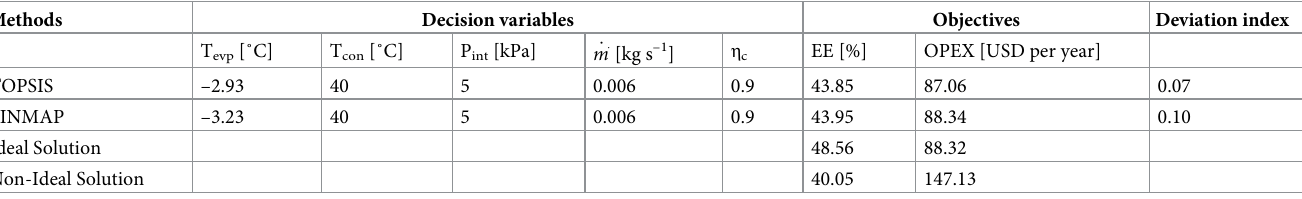
Table 6. Final solutions obtained via decision-making methods for the second scenario.